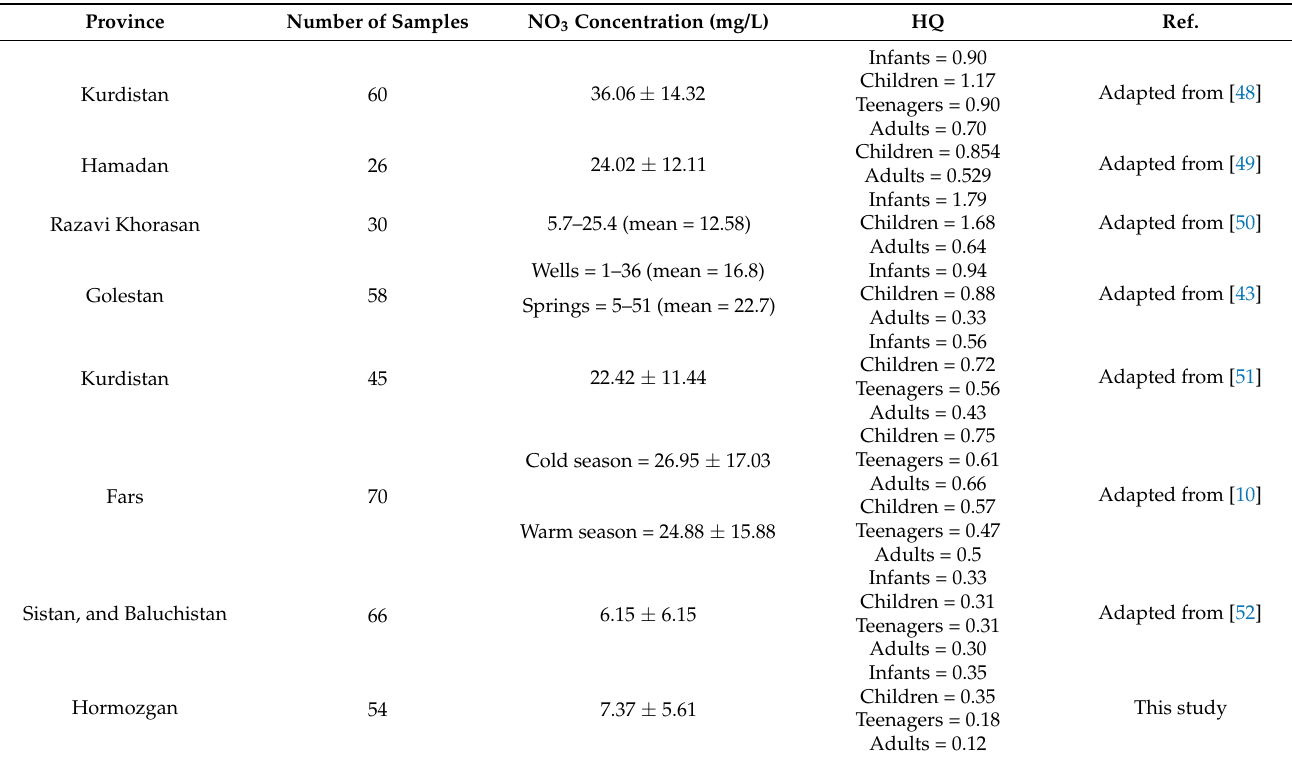
Table 3. Comparative study of nitrate contamination in groundwater of Iran country.